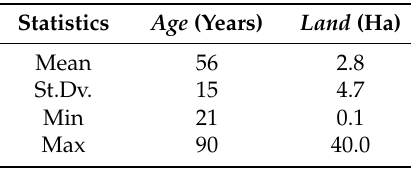
Table 4. Descriptive Statistics of the Continuous Exogenous